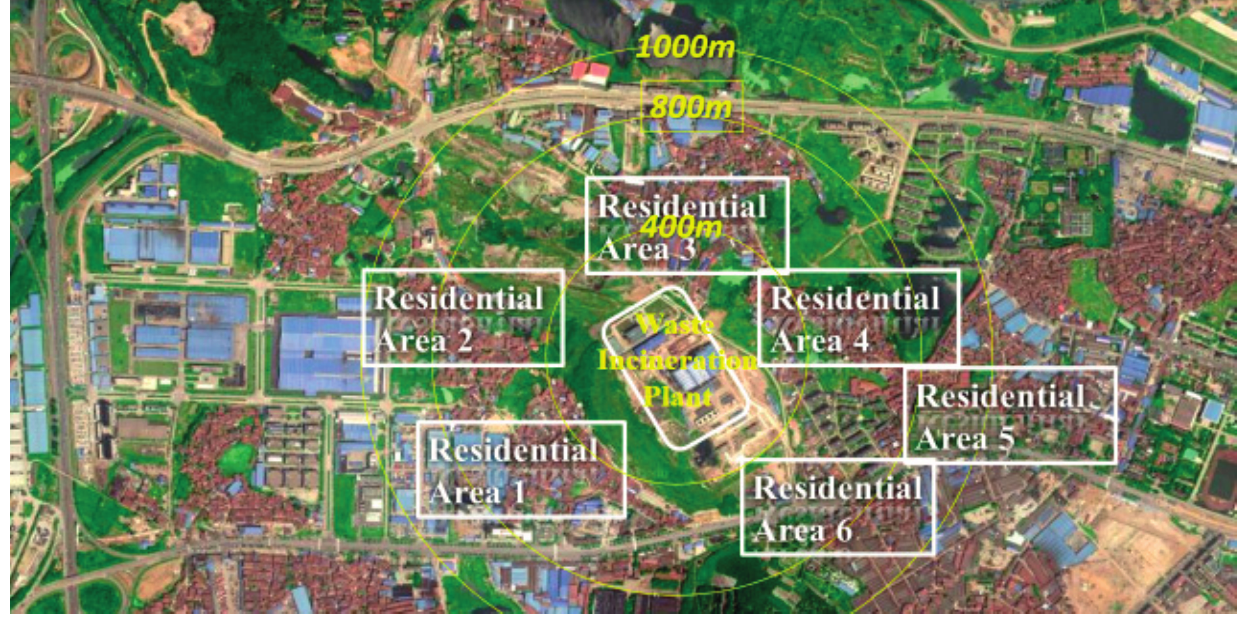
Figure 5. The location analysis of Guodingshan waste incineration